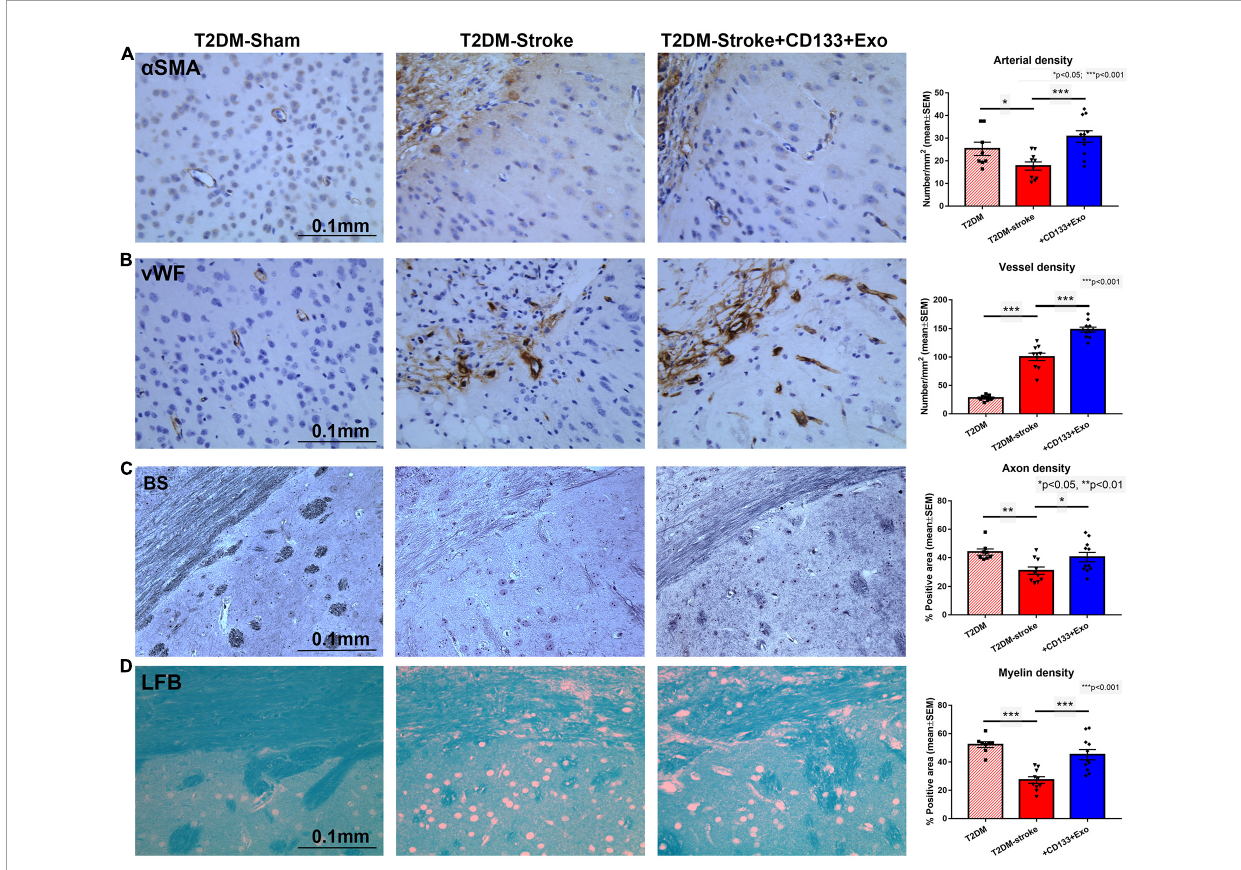
FIGURE2 CD133 + Exo treatment of T2DM stroke significantly increases vascular and white matter/axon remodeling. (A,B) CD133 + Exo treatment of T2DM-stroke significantly increases arterial blood vessel density ( α SMA) and vessel density (vWF) in the ischemic brain compared to T2DM-stroke mice. (C,D) CD133 + Exo treatment of T2DM-stroke significantly increases axon density (Bielschowsky silver, BS) and myelin density (Luxol fast blue, LFB) in the ischemic brain compared to T2DM-stroke mice at 28 days after stroke. T2DM ( n = 8), T2DM-stroke ( n = 12), and T2DM-stroke + Exo ( n =